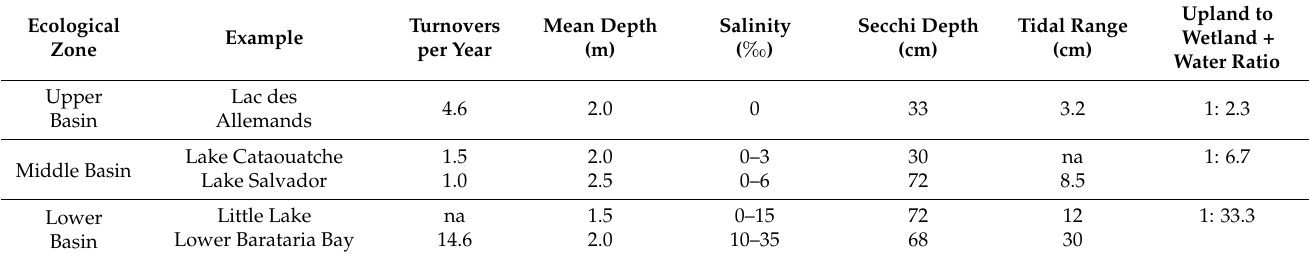
Table 1. Physical characteristics of water bodies in the Barataria Basin (modified from [44]; data collected 1973–1981; na: not available). Ecological